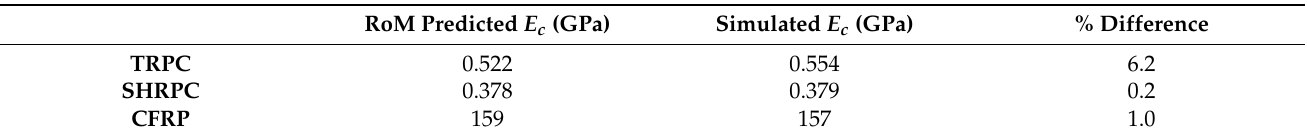
Table 3. Comparison of RoM predicted elastic modulus against simulation predicted elastic modulus for TRPC, SHRPC, and CFRP.